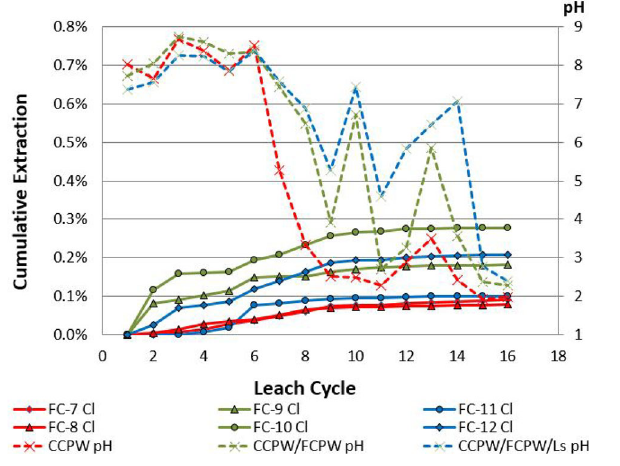
Fig. 5 Cumulative extraction of chloride and pH (dashed lines) in different leach cycles